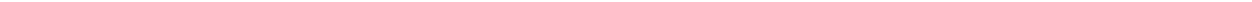
Fig. 4 Retinal angiogenesis in EC-speci fi c MafB KO mice. a Diagram of Mafb inactivation and mutant analysis. Tmx was injected at P1 – P3 for early induction in b and c or at P5 – P8 for late induction in d . Mice were sacri fi ced and analyzed at indicated ages. b – d IB4 staining of retinas from Mafb i Δ EC and control littermates (Control) at P6 ( b ) or P10 ( c ) following the early induction, and at P11 following the late induction ( d ). Scale bars represent 0.5 mm ( b upper ) and 300 μ m ( b lower , c and d ). e Analysis of control or Mafb i Δ EC retinal vasculature. The number of EC fi lopodia and sprouts were counted and normalized for 1 mm in length of vessels at the angiogenic front. The number of branching points were de fi ned as intersections between vessels within a fi eld of 1000 μ m 2 . n = 6, Error bars represent mean + s.d. * P < 0.05, ** P < 0.001, *** P < 0.0001; unpaired Student ’ s t -test; ns, not signi fi cant. f P6 control or Mafb i Δ EC retinas stained with IB4 ( white ), EdU ( red ), and anti-Erg1 antibody ( green ). Scale bars represent 150 μ m. Graph shows the ratio of EdU + ECs in Control and Mafb i Δ EC retinas at P6. n = 6, Error bars represent mean + s.d., *** P < 0.0001; unpaired Student ’ s t -test. g P6 control or Mafb i Δ EC retinas stained with IB4 ( green ) and anti-collagen IV (ColIV; red ). White dots indicate fi lopodia. Scale bars represent 300 μ m ( upper row ) and 25 μ m ( lower row ). h Length of sprouts in P6 control or Mafb i Δ EC retinas. n = 6, Error bars represent mean ( red line ) ± s.d., P < 0.0001; unpaired Student ’ s t -test. i P6 control or Mafb i Δ EC retinas stained with IB4 ( green ) and anti-Dll4 ( red ). Scale bars represent 75 μ